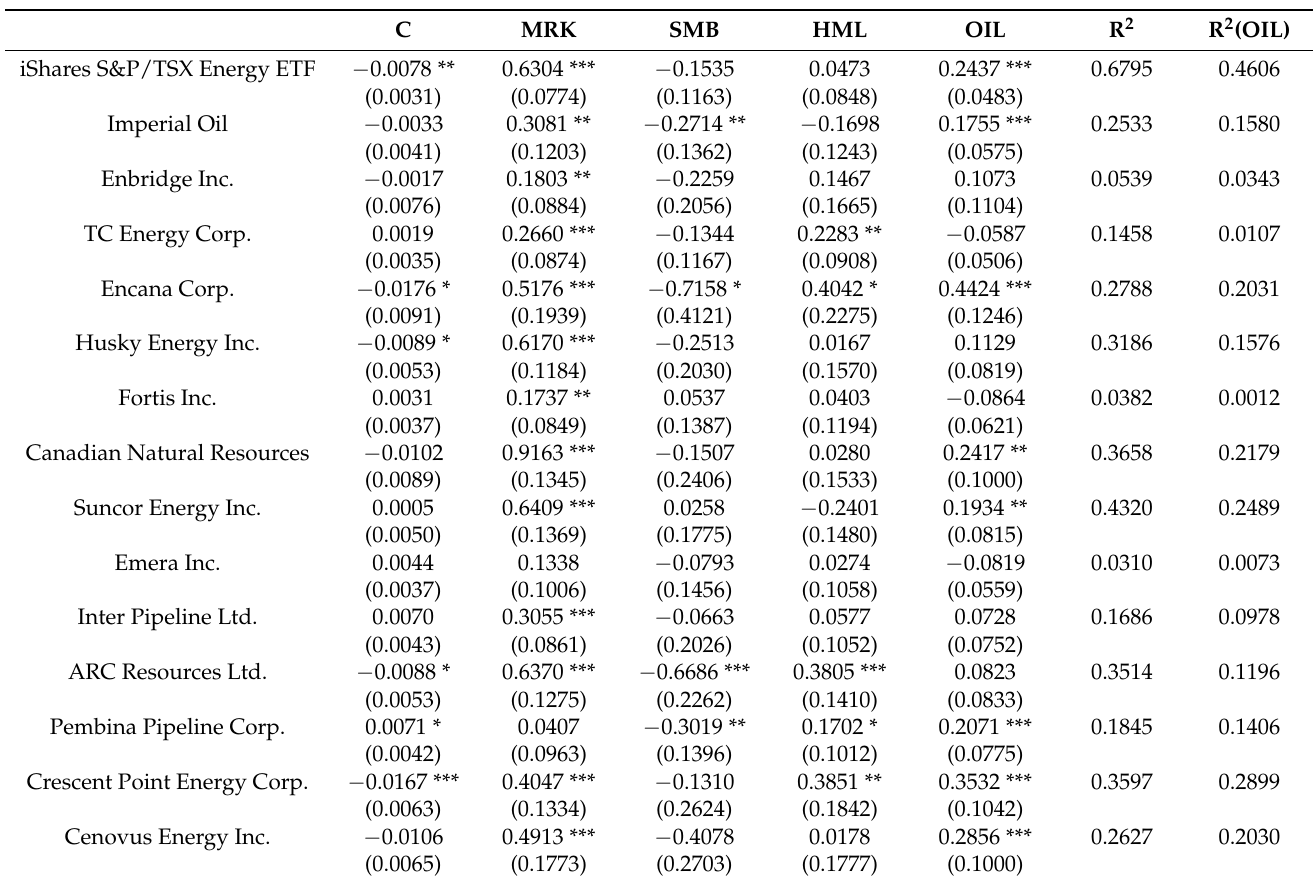
Table 7. Regression results for the 2009–2018